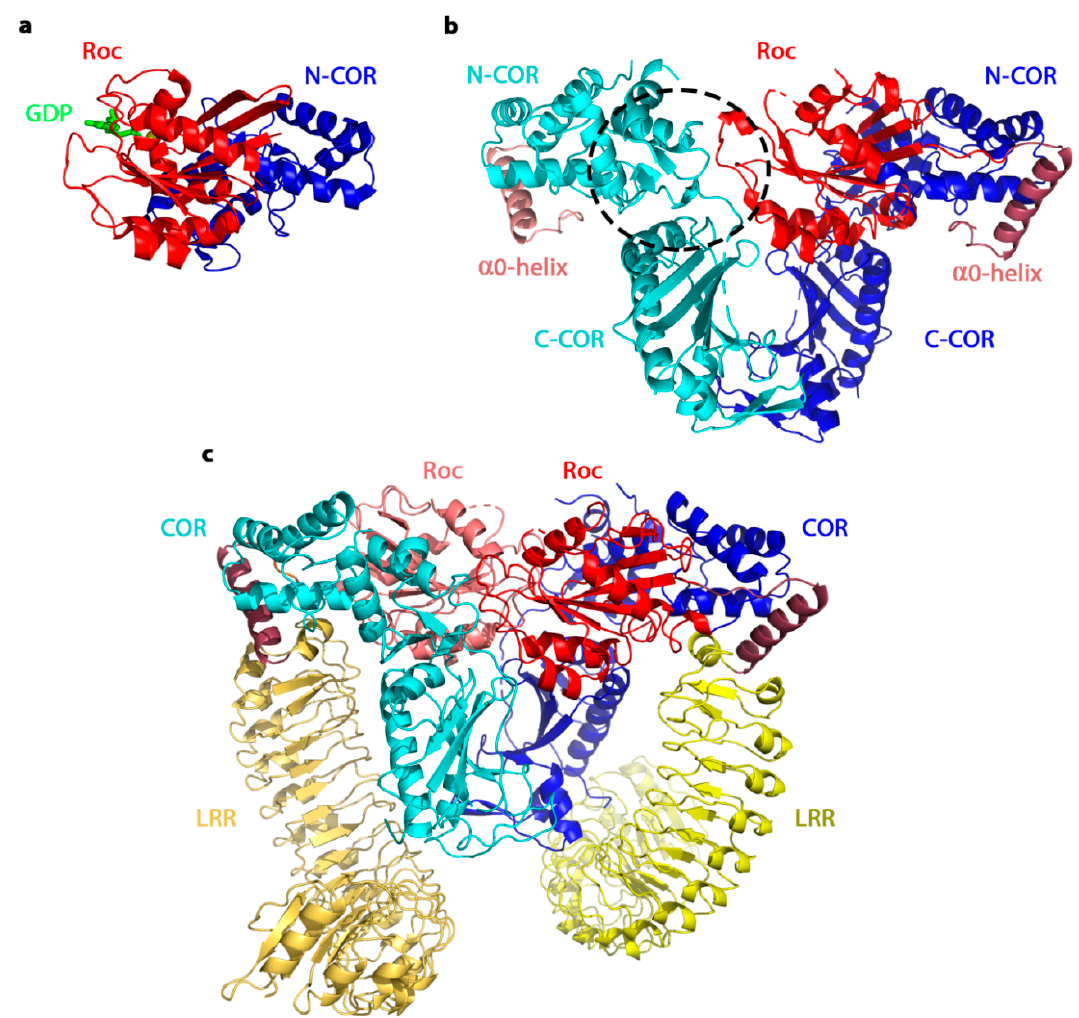
Figure 3. The C-terminal half of the COR domain is important for dimerization (pdb: 3DPU, 4WNR and 6HLU). ( a ) The crystal structure of the RocCOR ∆ C domain construct from the Roco2 protein of Methanosarcina barkeri reveals a monomeric conformation [33]. ( b ) The crystal structure of the RocCOR domain construct from the Roco protein of Chlorobium tepidum shows dimer formation via the C-terminal COR domains. The COR domain contains two subdomains: an N-terminal, mainly α -helical domain with a short antiparallel β -sheet (N-COR), and a C-terminal domain with a β -sheet surrounded by α -helices and a β -hairpin involved in dimerization (C-COR). Only one Roc domain is resolved in the structure, presumably due to the flexibility of the other Roc domain. The putative site of the second Roc domain is indicated with a black dotted line [33]. ( c ) The crystal structure of the LRR–RocCOR domain construct from Ct Roco. This structure reveals the second Roc domain and the orientation of the LRR domains with respect to the other domain. Apart from the COR–COR interactions, also Roc–Roc and Roc–COR interactions contribute significantly to the dimer interface [17].